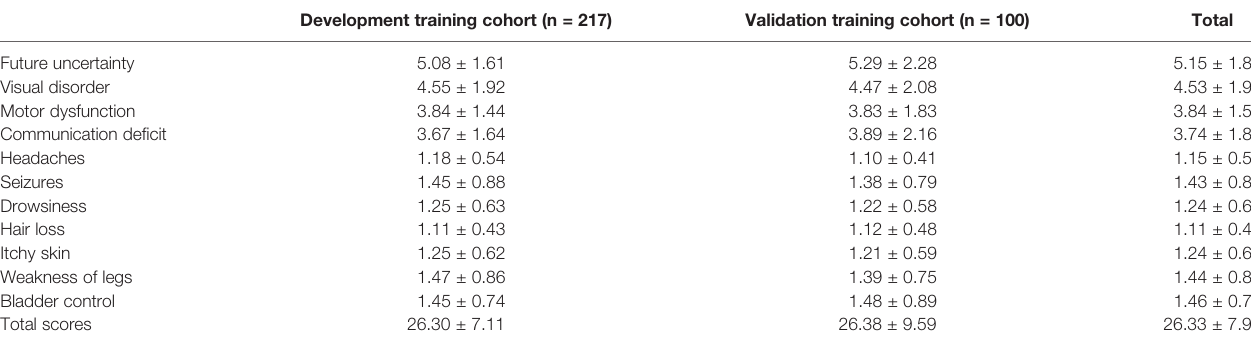
TABLE 3 | BN20 scores of patients in the development and validation